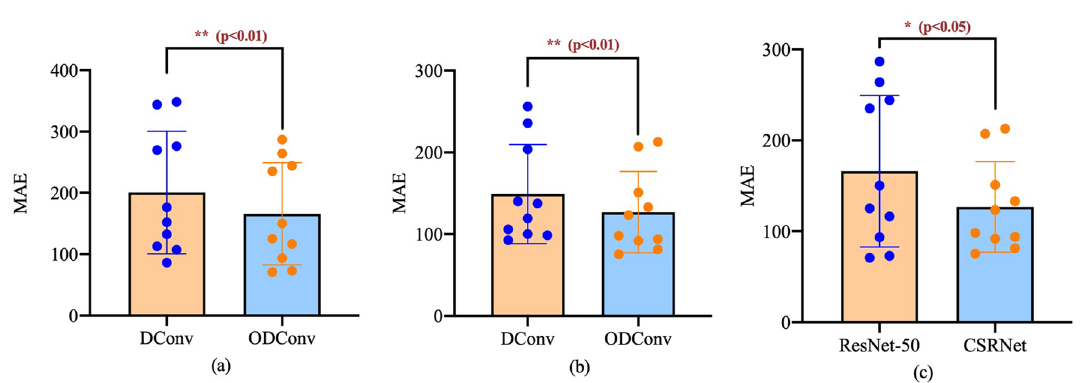
Figure 9. Comparisons of the ODConv and DConv on the ResNet-50 and CSRNet are shown in ( a ) and ( b ), respectively, and comparisons of the ODConv on the CSRNet and ResNet-50 are shown in ( c ). The results of the significance level are indicated by the crimson characters on the top of each